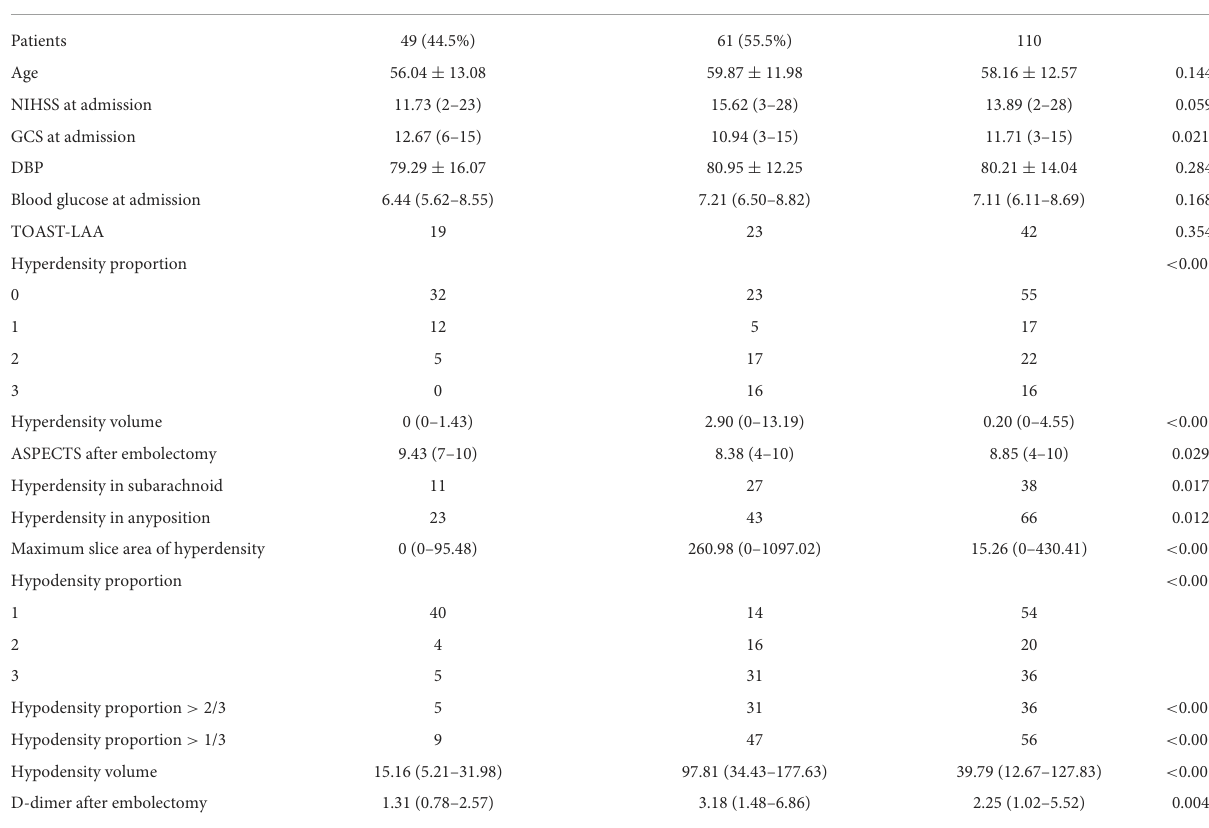
TABLE 1 Summary of the important characteristics comparing AIS patients with futile recanalization vs. meaningful